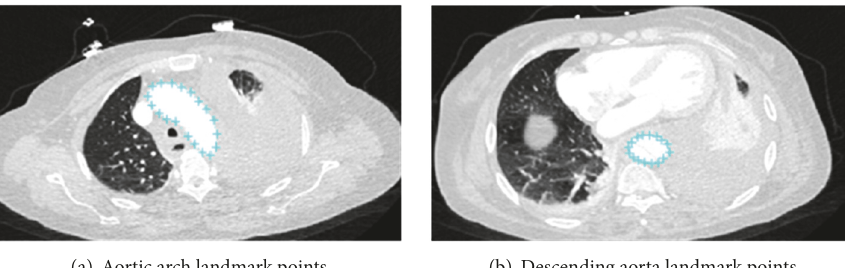
Figure 3: Landmark points